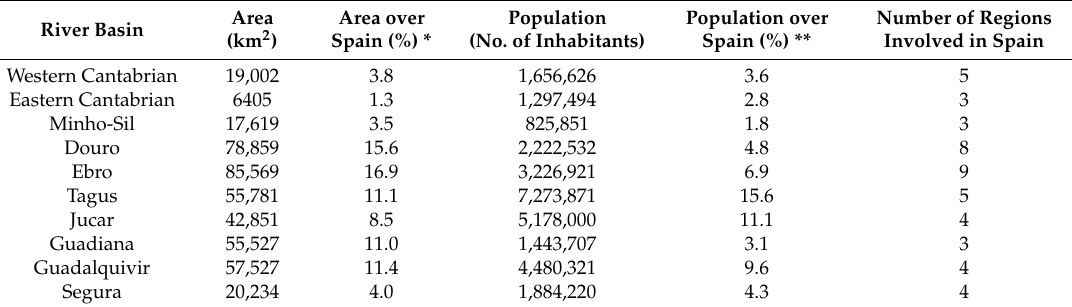
Table 1. Main characteristics of the Spanish inter ‐ regional water basins.